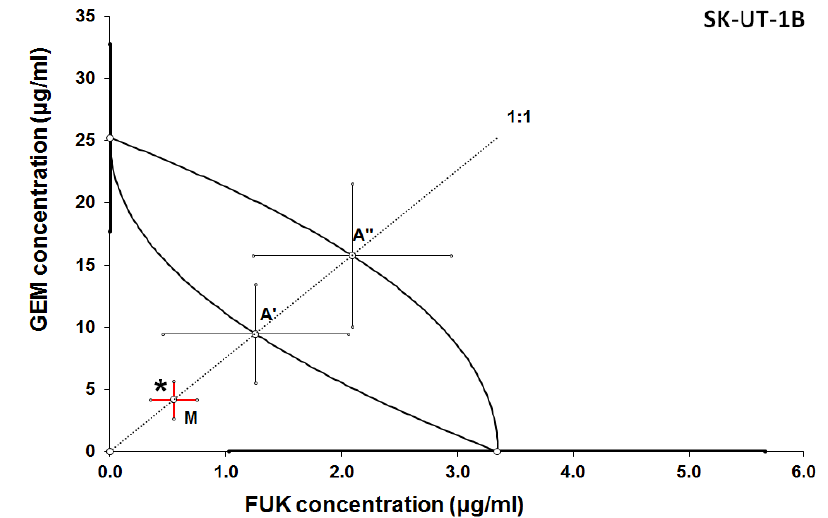
Figure 3. Isobologram showing interaction between gemcitabine (GEM) and fucoidan (FUK) with respect to their anti-proliferative effects in the cancer cell line (SK-UT-1B) measured in vitro by the MTT assay. Because the experimentally-derived IC 50 mix value is placed significantly below the point A’, the interaction between GEM and FUK for the cancer cell line SK-UT-1B is supra-additive (synergistic). * p < 0.05 vs. the respective IC 50 add values.